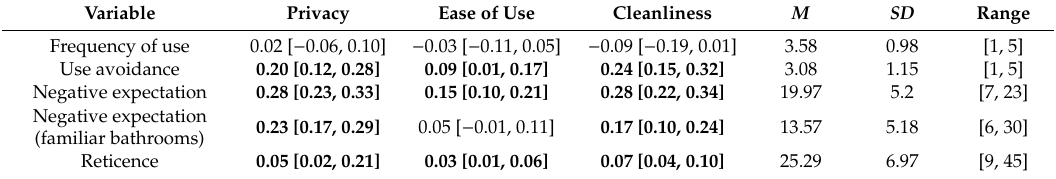
Table 3. Descriptive statistics of variables and latent correlations between variables and